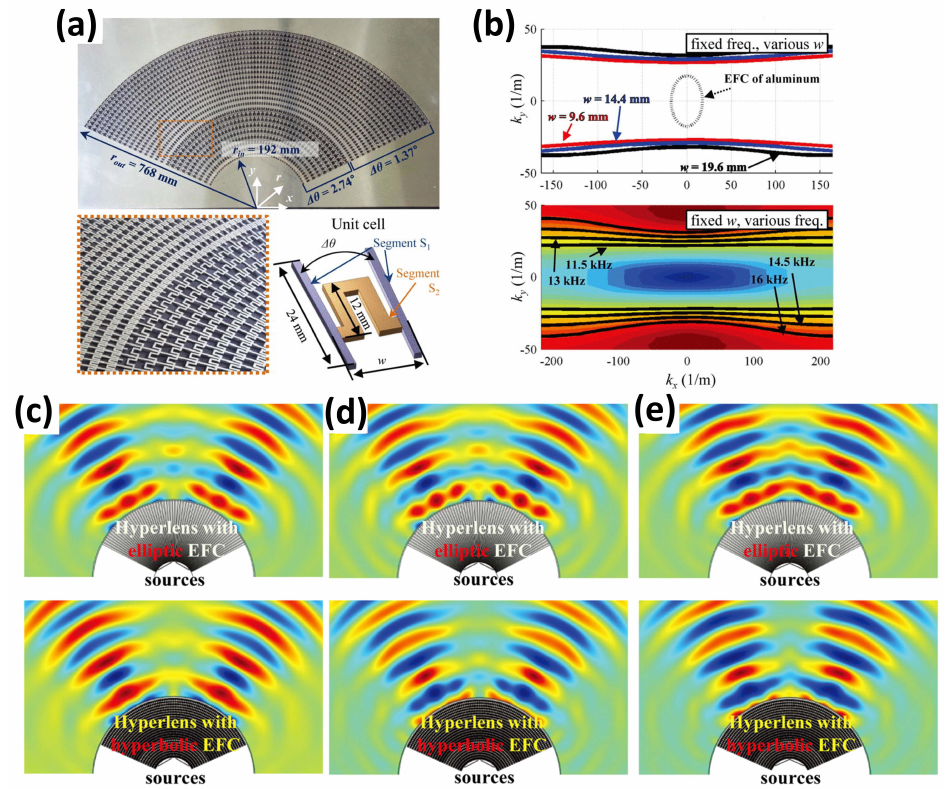
Figure 6. ( a ) Elastic hyperlens (top), close-up view (lower left) and geometry of the unit cell (lower right); ( b ) hyperbolic EFCs at 15 kHz for varying the width w of unit cell (upper). Hyperbolic EFCs for varying frequencies with fixed width 14.4 mm (lower); ( c ) Comparison of the hyperlenses having hyperbolic (upper) and elliptic EFCs (lower) with which the distance between two sources is 0.48 λ ; ( d ) 0.45 λ ; ( e ) 0.41 λ . ( a – e ) adapted from